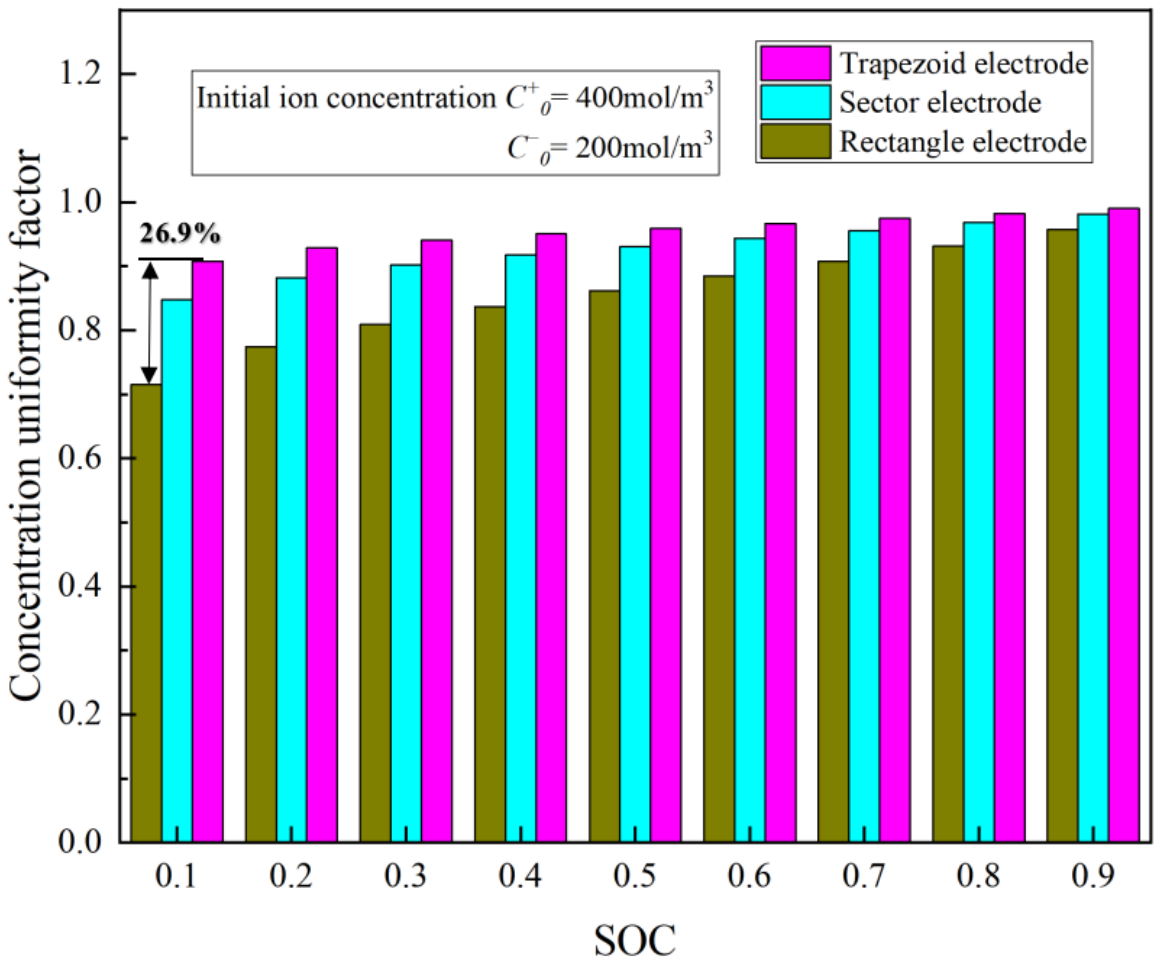
Figure 6. Variations in the uniformity factor during the discharge process under different flow fields.